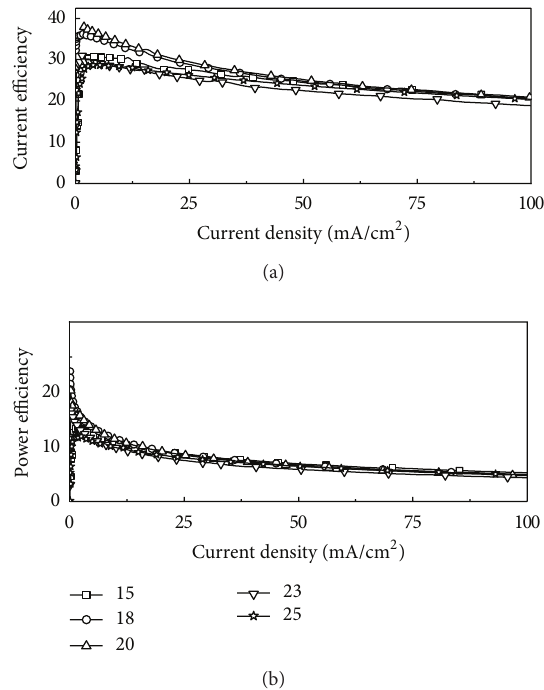
Figure 3: Current efficiency-current density characteristics of devices A1, A2, A3, A4, and A5 (a) and power efficiency-current density characteristics of the devices